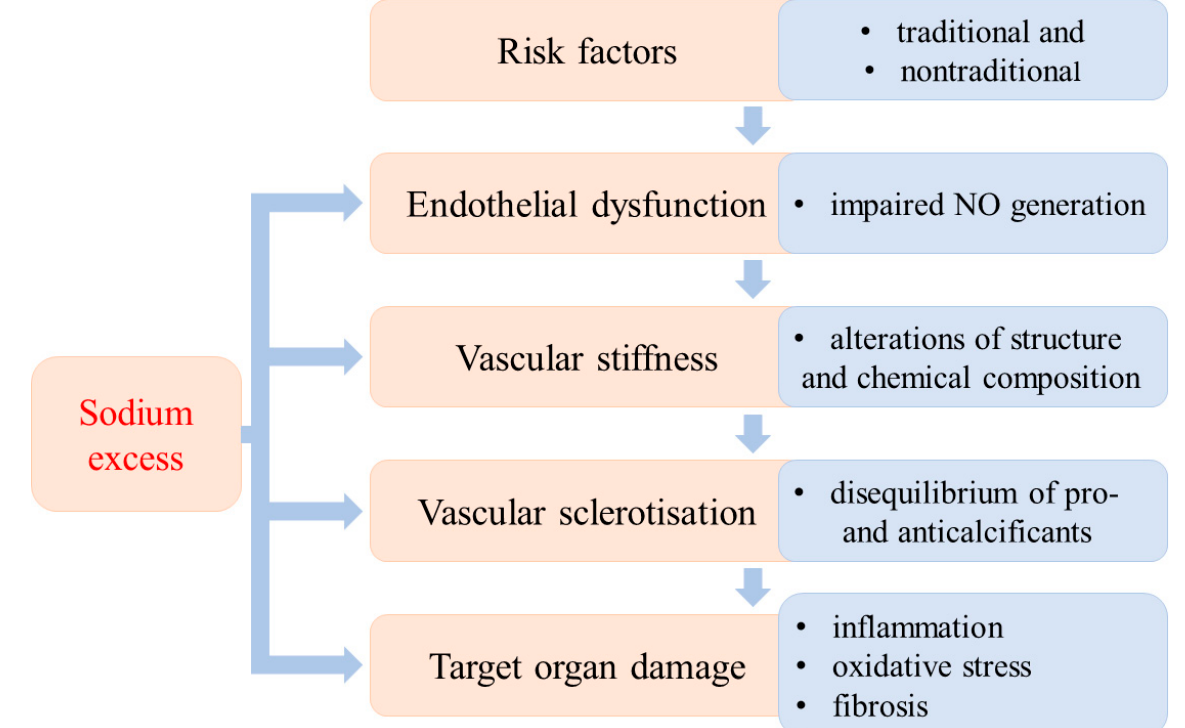
Figure 1. Sequential stages of the evolution of hypertensive disease and the impact of excess sodium.